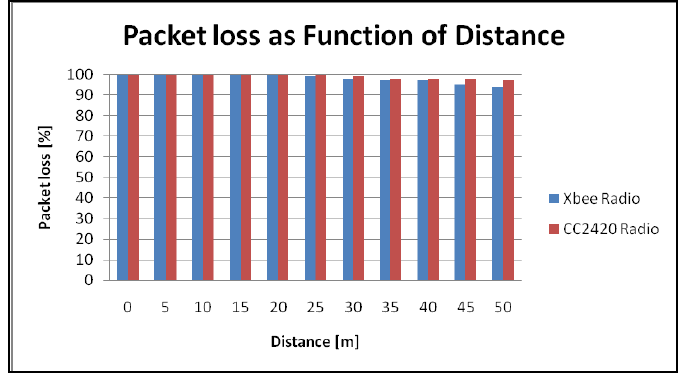
Figure 7. Packet loss as a function of distance.